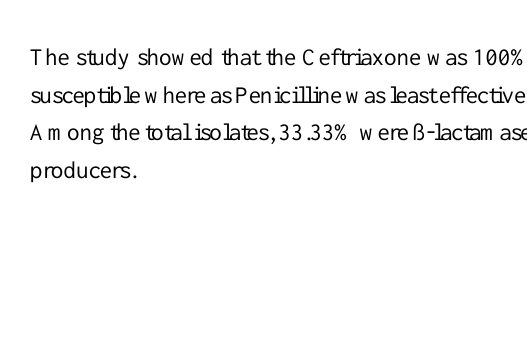
Figure 3: Educational Status of Infected Patients.